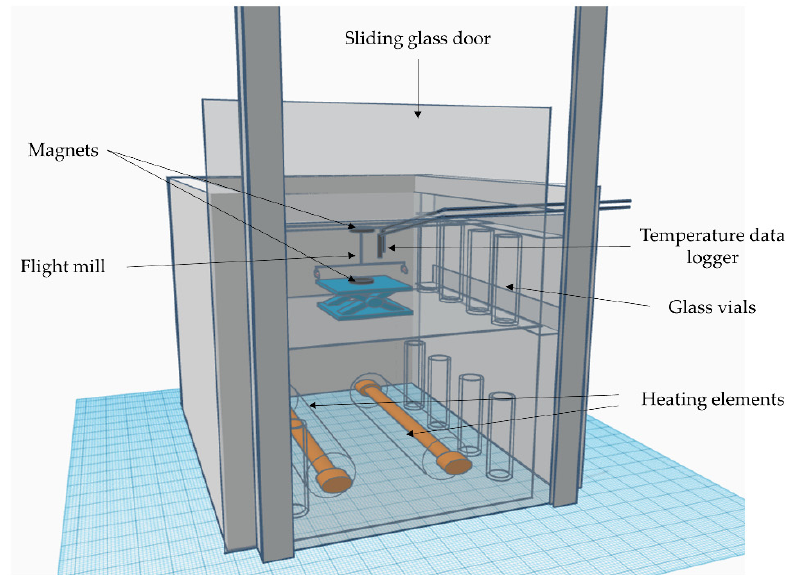
Figure 1. Diagram of the temperature-controlled flight mill used to test the flight capacity of Diaphorina citri under different temperatures.